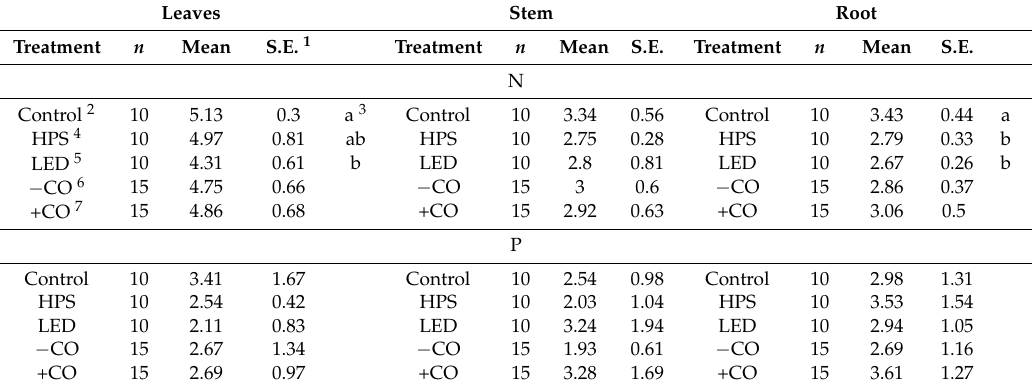
Table 3. The main effects of lighting spectra and chitosan oligosaccharide addition on N and P concentrations in Fragrant rosewood ( D. odorifera ) seedlings.